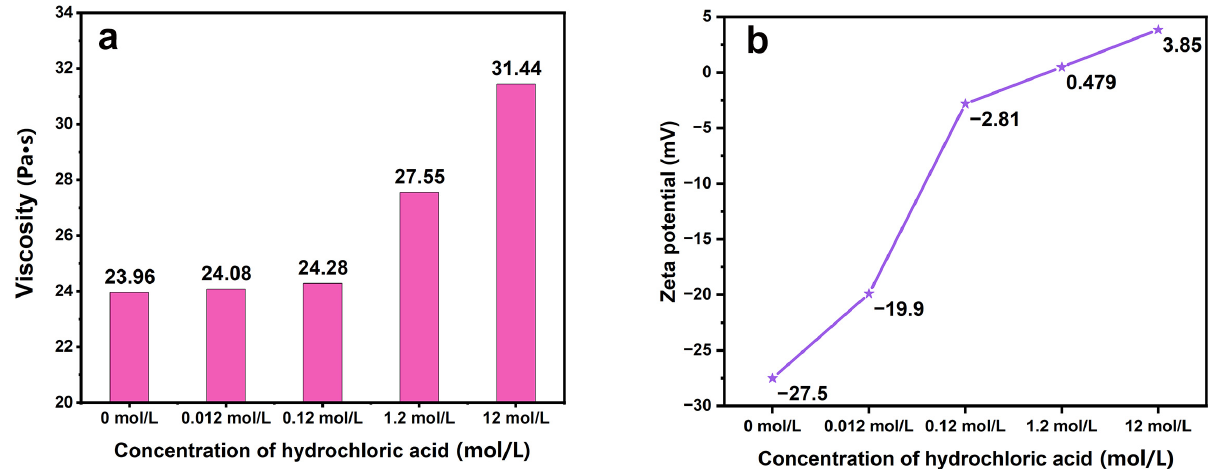
Figure 3. ( a ) Viscosity and ( b ) zeta potential of GOS treated with different concentrations of HCl.